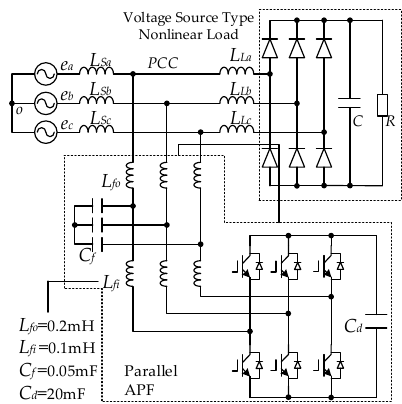
Figure 1. Parallel APF compensation voltage type nonlinear load main circuit .